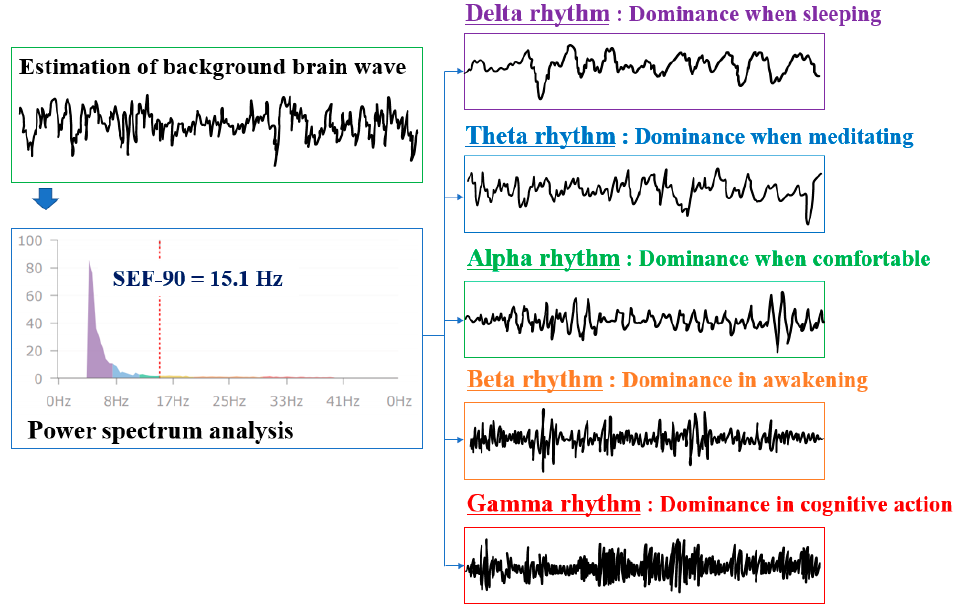
Figure 4. Power spectrum analysis of background brain wave and classification of brain wave rhythms for the degree of brain activity according to frequency.